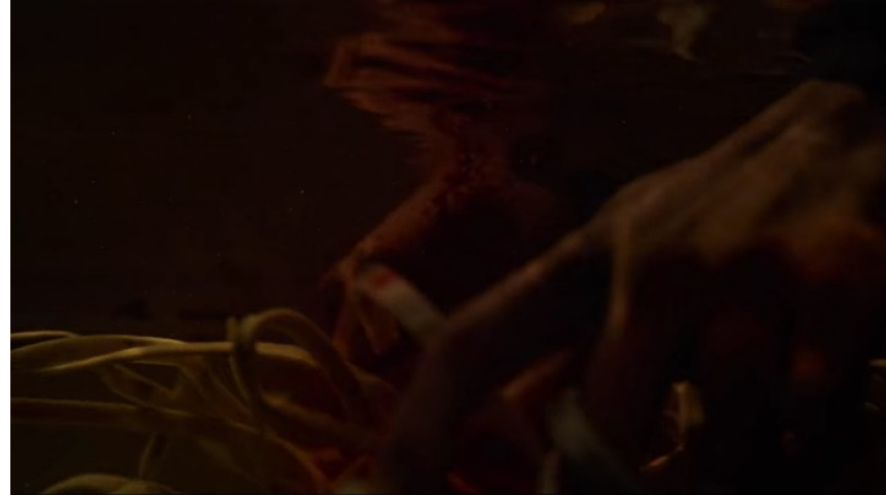
Figure 11. The Power of the Dog . Netflix.